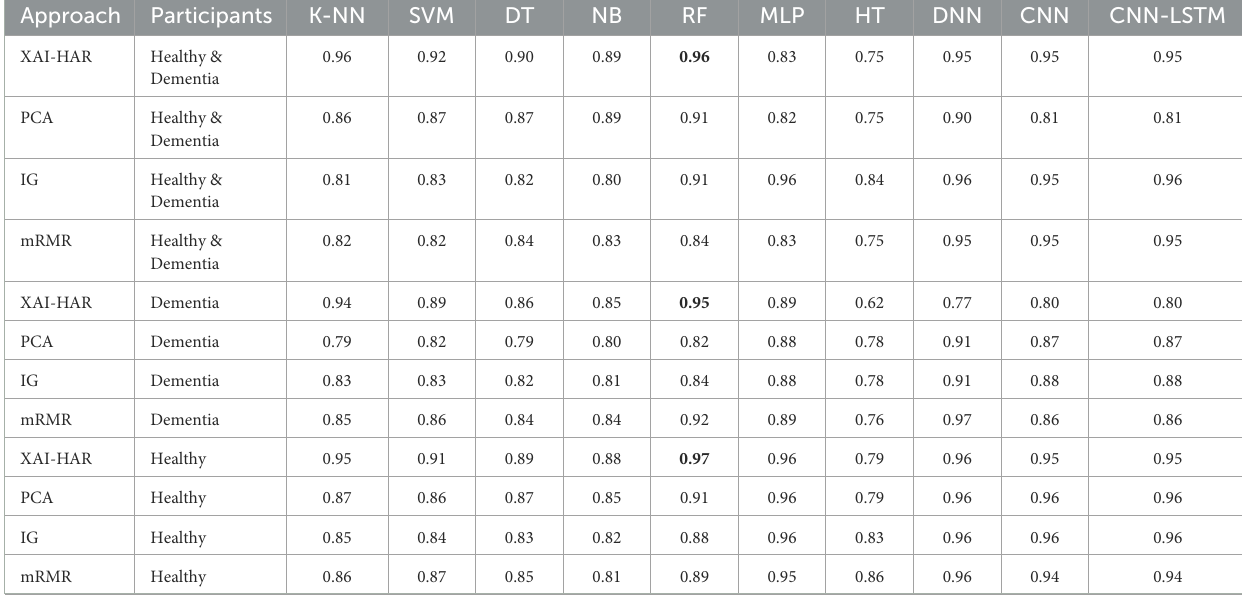
TABLE 3 F-score-based comparison of XAI-HAR with other feature selection and classification techniques for activities in CASAS Dataset (27).